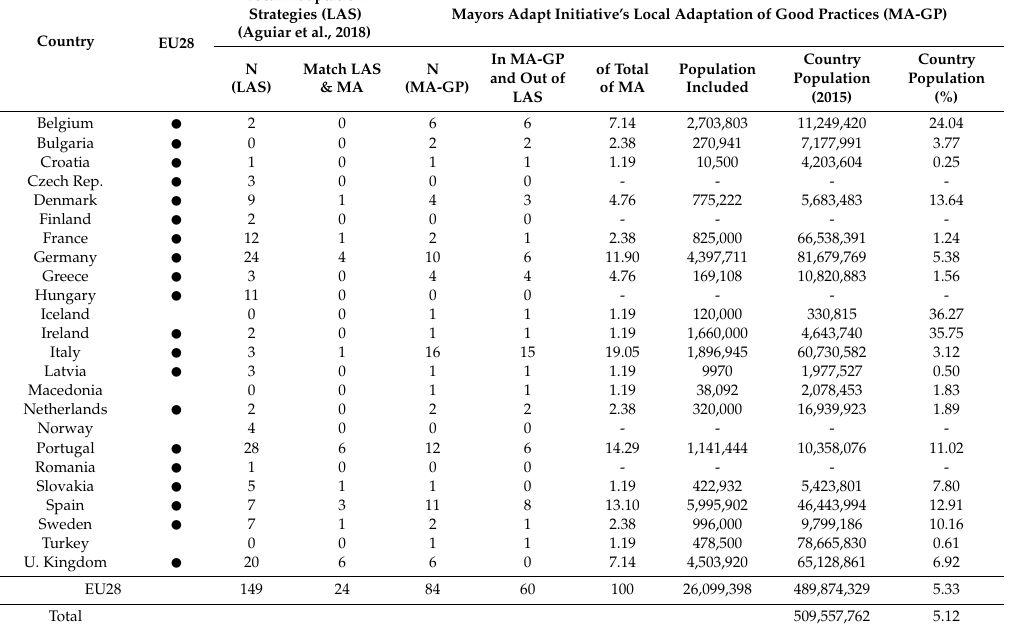
Table 2. Comparison between the case studies of Aguiar et al., 2018 [18] and the Mayors Adapt (MA) initiative’s local Good Practices [19]. Distribution of case studies by country and population and population coverage of the Mayors Adapt initiative’s local Good Practices [19]. Source of population data, World Bank